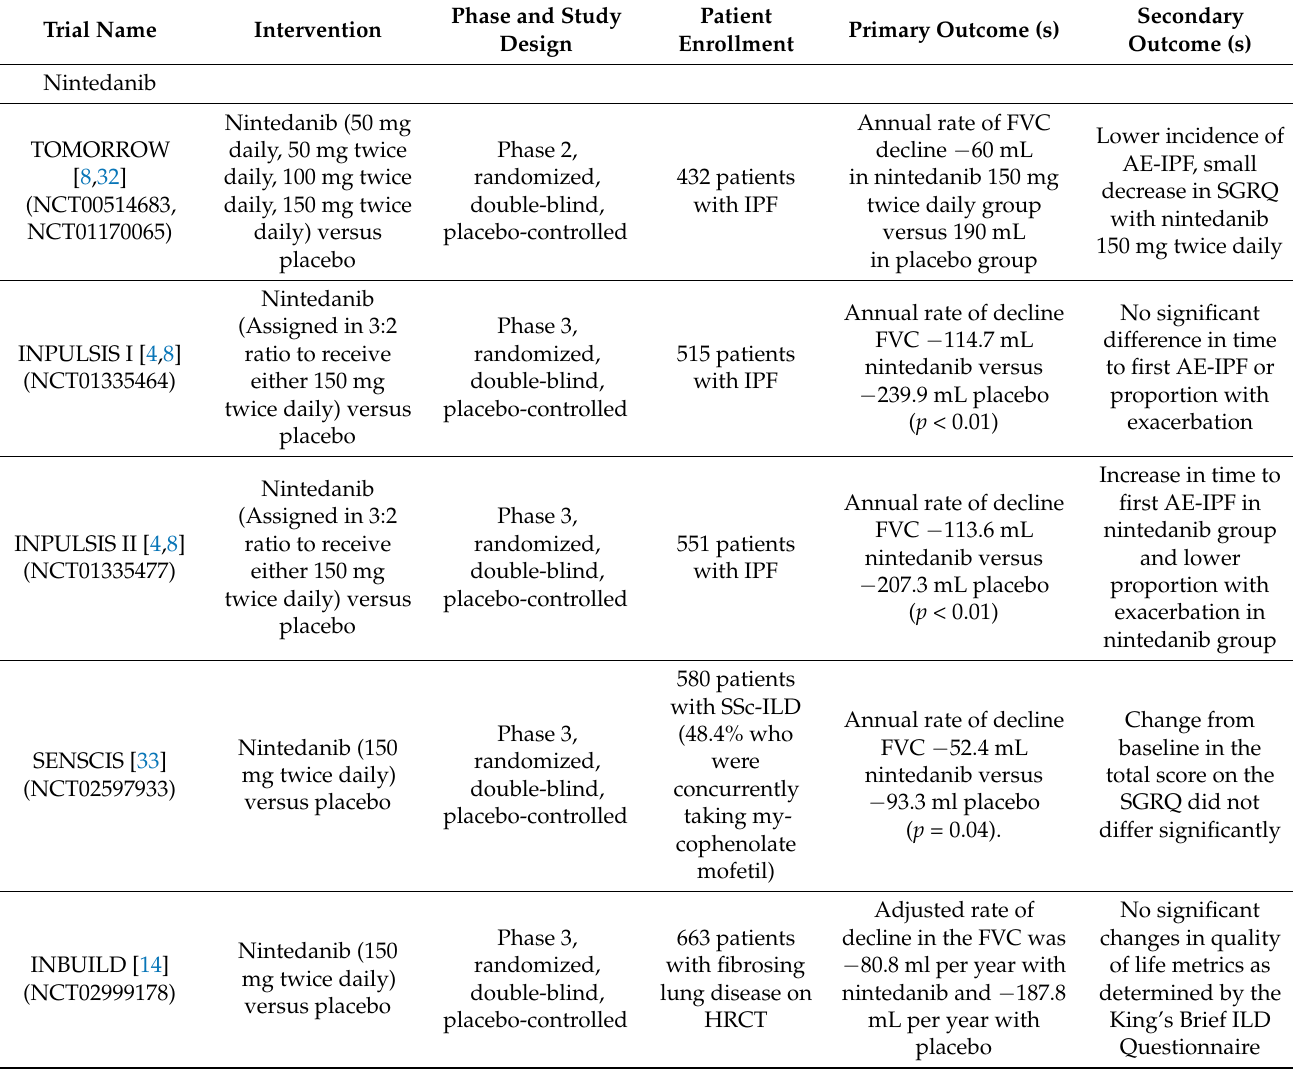
Table 1. List of major antifibrotic trials to date that have included nintedanib as an intervention. FVC: Forced vital capacity; SGRQ: St. George’s Respiratory Questionnaire; AE-IPF: Acute exacerbation of